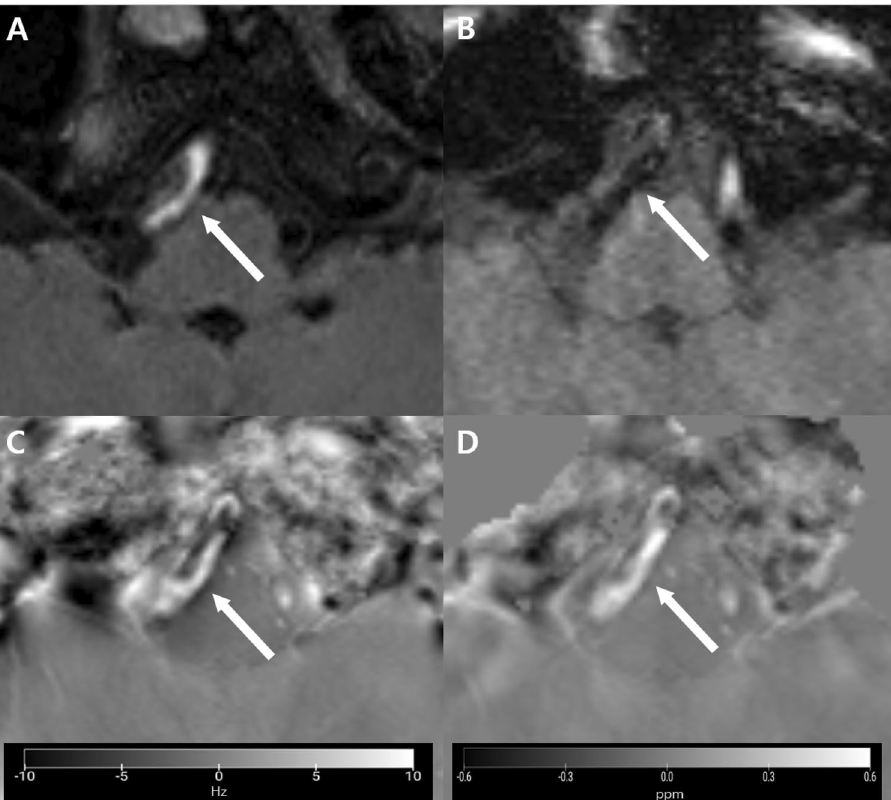
Figure 1. A dissecting intramural hematoma in a 50-year-old male patient. ( A ) An axial precontrast T1-weighted image of vessel wall magnetic resonance imaging (VW-MRI) shows eccentric T1 hyperintensity (arrows) in the wall of the right intracranial vertebral artery, suggesting dissecting intramural hematoma. ( B ) A magnitude image shows dark signal intensity of the lesion (arrows). ( C ) A phase image shows a high signal intensity lesion of the lesion (arrows). ( D ) The lesion has high susceptibility values (mean, 0.328 ppm; median, 0.319 ppm) on quantitative susceptibility mapping (QSM) (arrows), suggesting the paramagnetic nature of the hematoma. The figures were generated using the MRIcroGL version 1.2.20220720 (https:// www. nitrc. org/ proje cts/ mricr